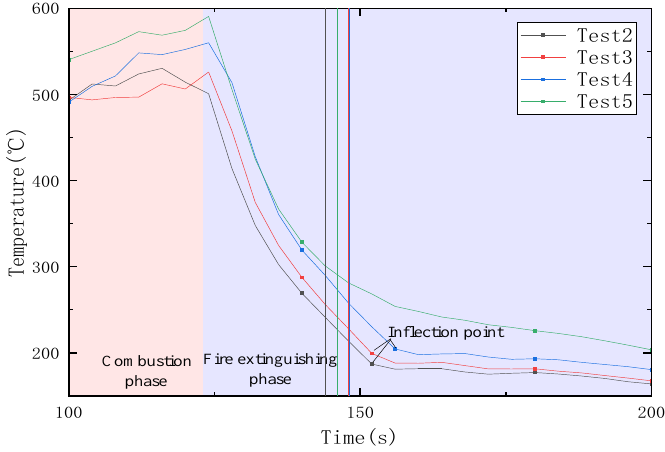
Figure 5. Temperature above the fire source under different nitrogen injection flow.